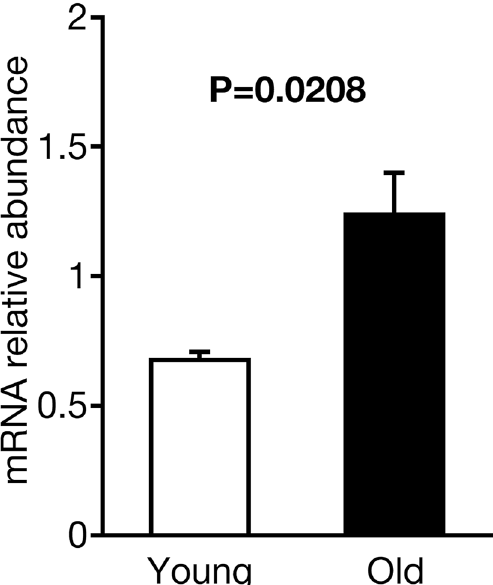
Figure 4. Upregulated G-protein-coupled receptor 61 (GPR61) expression in the anterior pituitary of old cows. Comparison of GPR61 mRNA expression measured using RT-qPCR. There were significant differences between the groups. Statistical analysis was conducted using two-tailed unpaired t